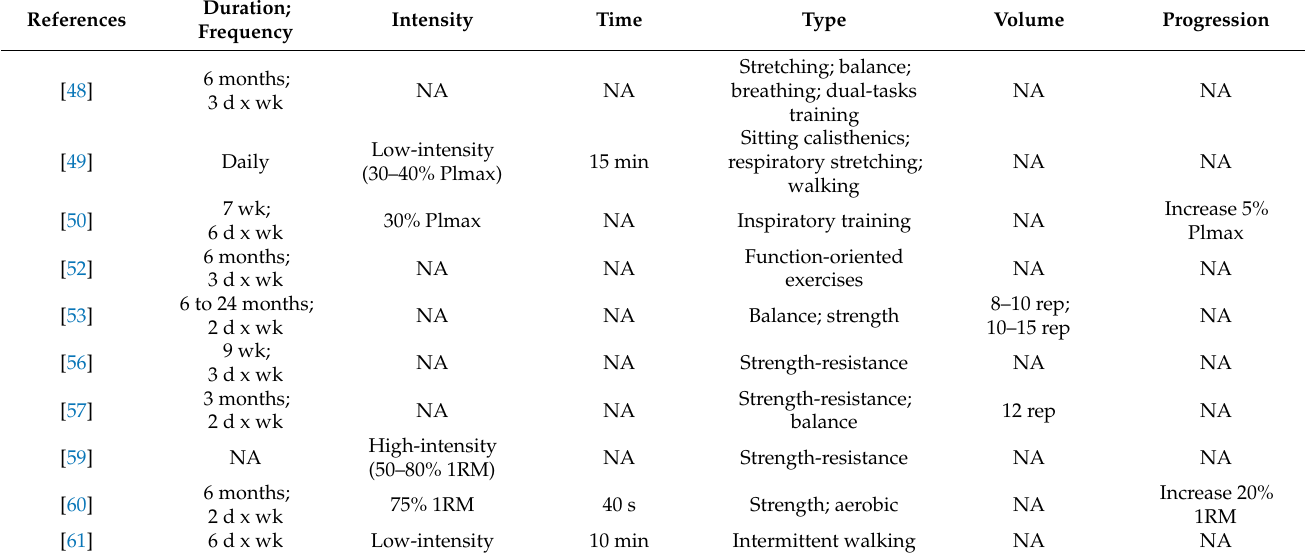
Table 3. The principles of exercise prescription of chronic diseases before COVID-19.